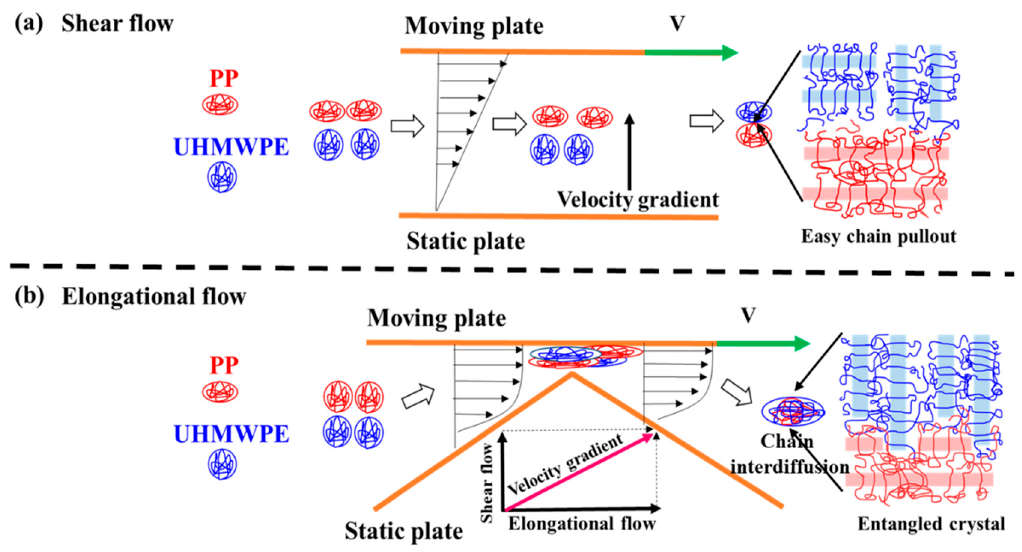
Figure 6. Proposed schematic representation of UHMWPE/PP interfaces by different processing methods: ( a ) by shear flow; ( b ) by elongational flow.